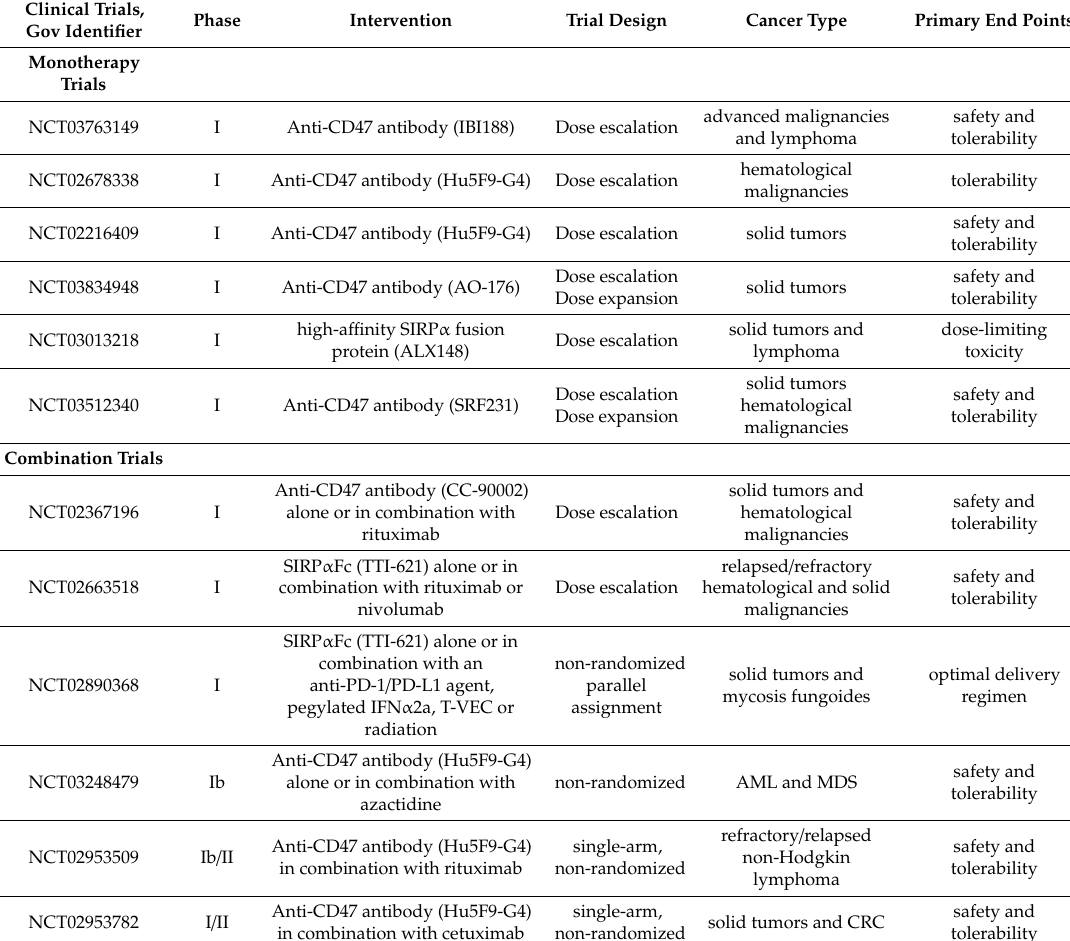
Table 2. Clinical trials investigating phagocytosis checkpoint